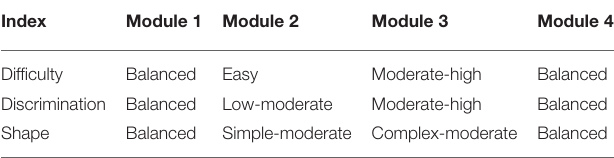
TABLE 1 | The targeted properties of the items in four modules.